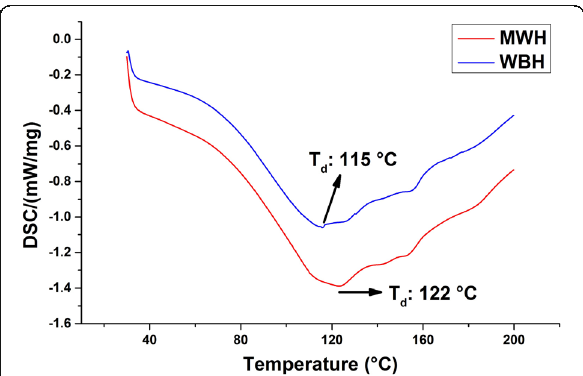
Fig. 4 DSC curves of aluminum tanned skin pieces under different heating